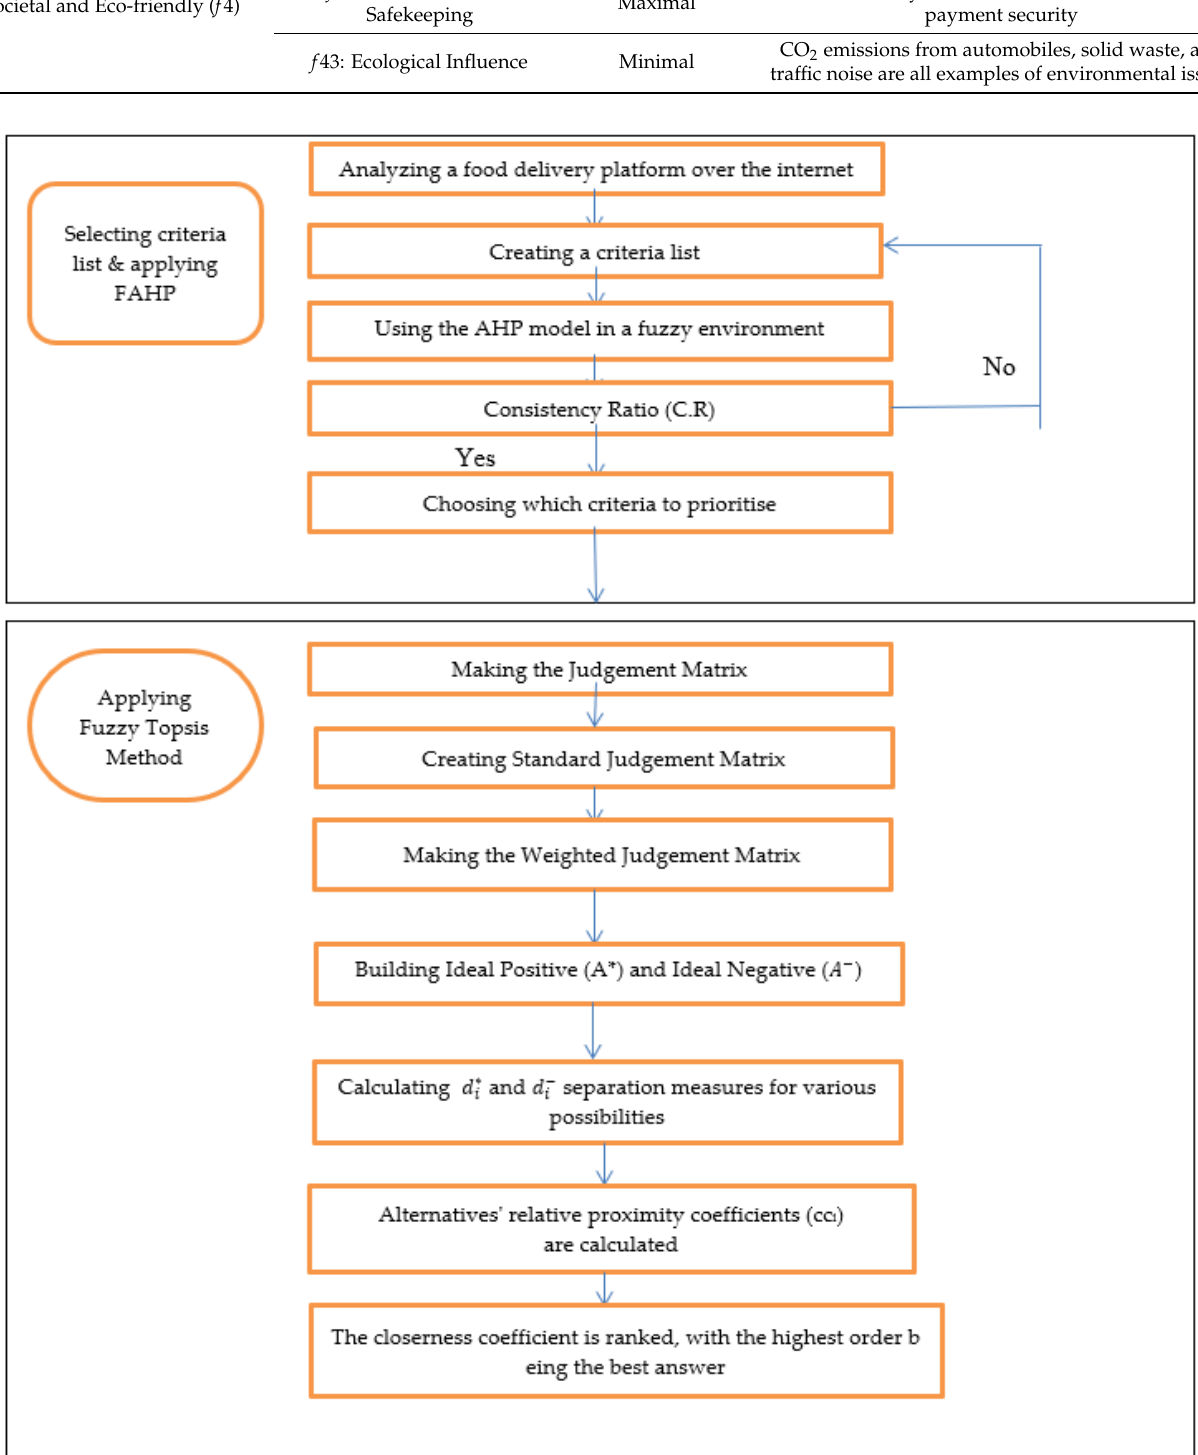
Figure 1. Evaluation process and Selection of online food delivery.